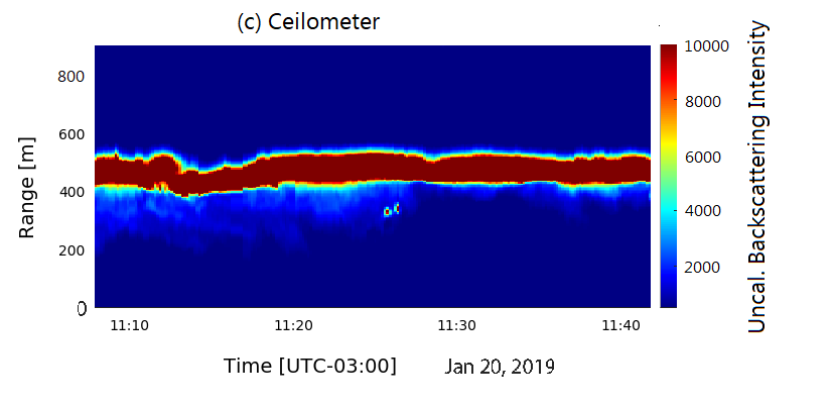
Figure 8. ( a ) radar reflectivity retrieval, calculated using the internal calibration and the UAV based distance calibration presented in Section 3. It also shows the time averaged reflectivity profile; ( b ) shows the Uncalibrated Doppler Velocity retrievals. Positive values indicate movement towards the